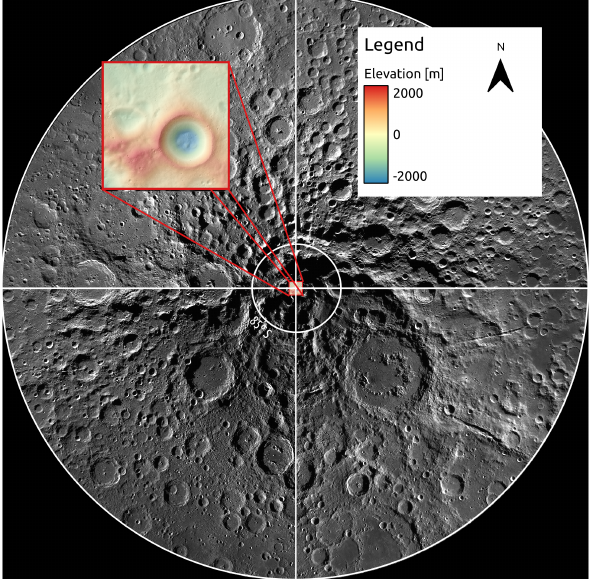
Figure 1. Location of the Digital Terrain Model (DTM) within the south pole of the Moon. The elevation shows the extreme topography of the